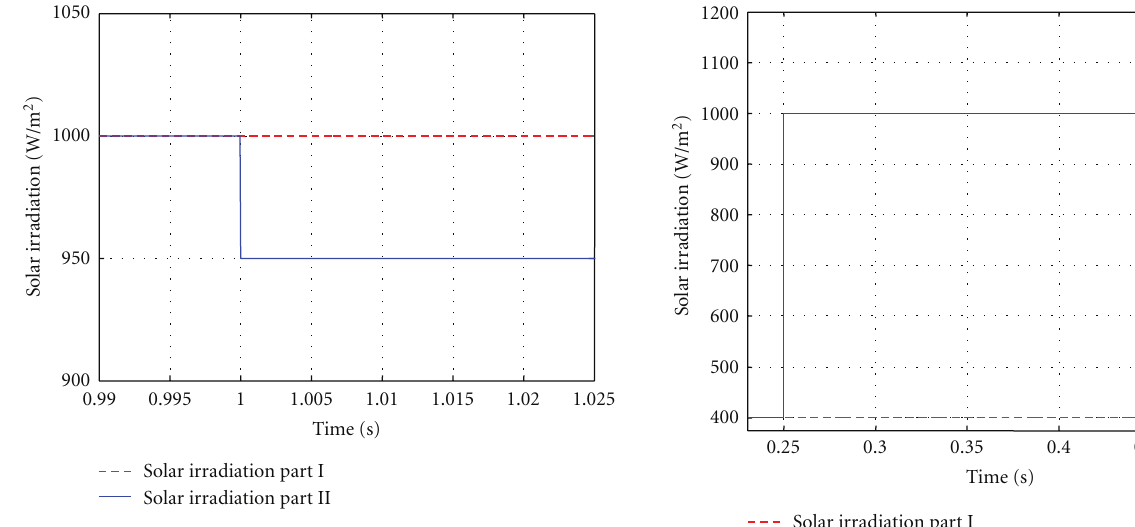
Figure 22: Partial shading of solar irradiation change.